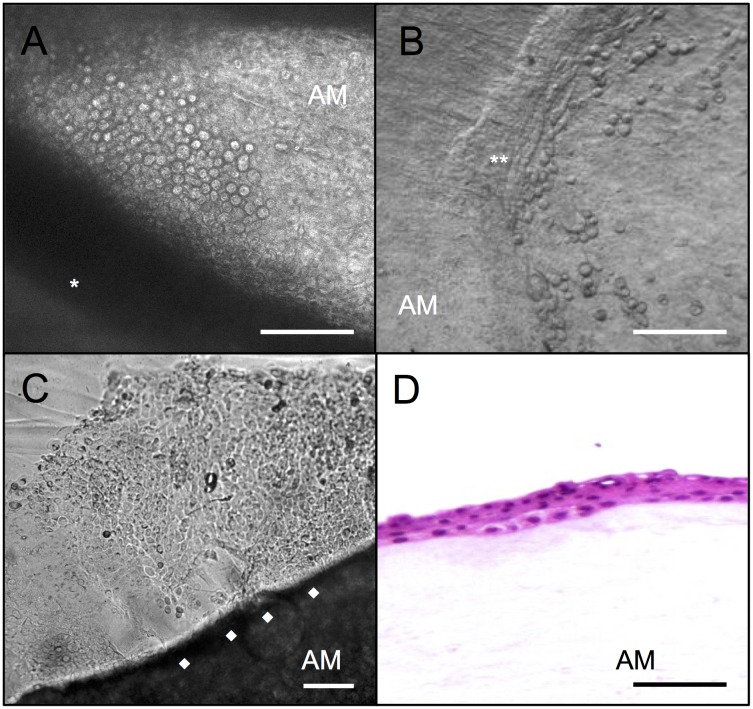
Limbal explant outgrowth of cells cultured on amniotic membrane after 3 days of culture and after 3 weeks of culture.The cells adjacent to the limbal explants were more uniform, smaller and had larger nuclei (A). In the first week of culture an epithelial line (B) was observed on AM (**), which after 3 weeks of culture reached the AM border (C) (◆) (A,B: Magnification:10x; C: Magnification:4x). Light microscopy showed limbal epithelial cells cultivated on AM (stromal side) produced a well-stratified cell layer (D); (HE: 10x). (*; explant; AM: amniotic membrane; HE: hematoxylin and eosin). Bars, 100 μm.